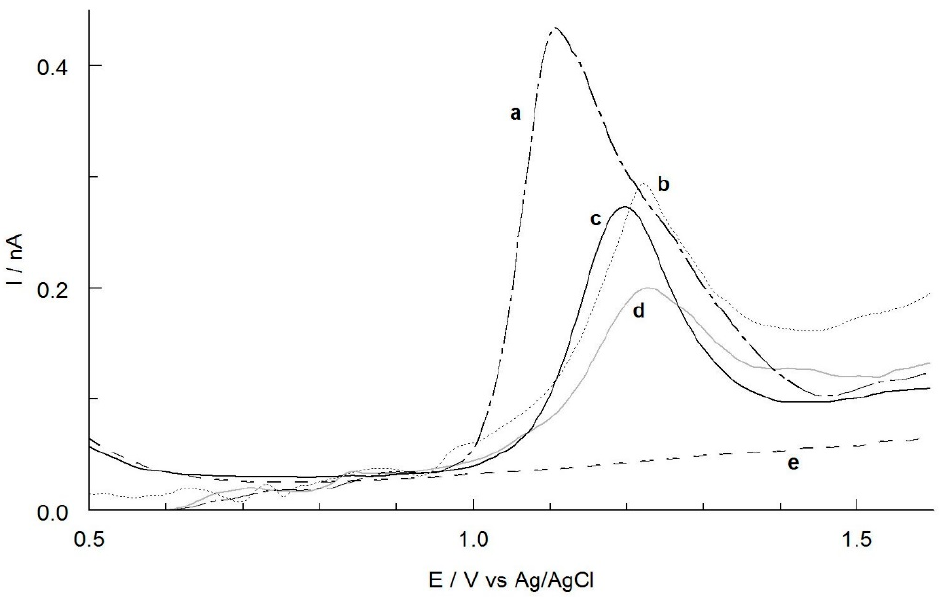
Figure 1. DPV curves of thymol (15 µ g mL − 1 ) oxidation recorded in solutions of HAc-AN (8:2, v / v ) with 0.1 mol L − 1 NaClO 4 on: (a) gold, (b) carbon fiber, (c) platinum, (d) palladium microelectrode.